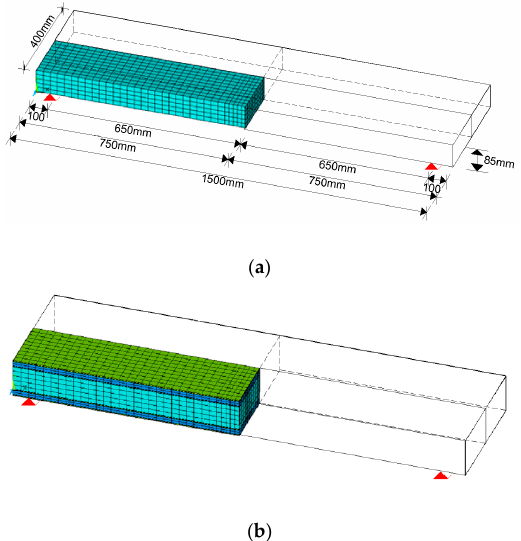
Figure 12. ( a ) Schematic arrangement and geometry of control specimen and ( b ) model for specimen